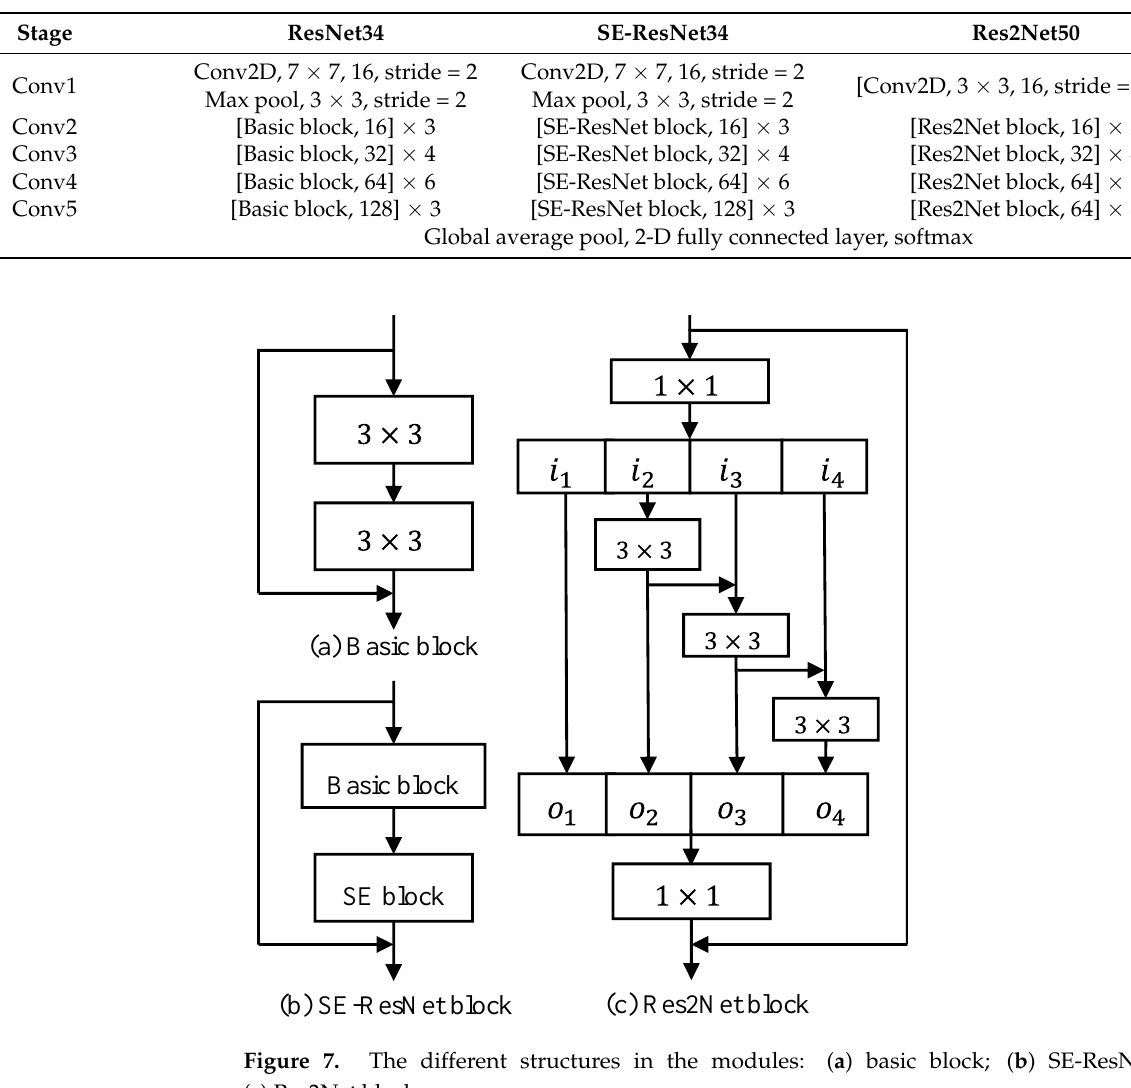
Table 2. The overall model architectures of ResNet34, SE-ResNet34, and Res2Net50. The type of residual block, and the number of channels, are specified inside the brackets, the repeat times of each block on one stage are specified outside the brackets.